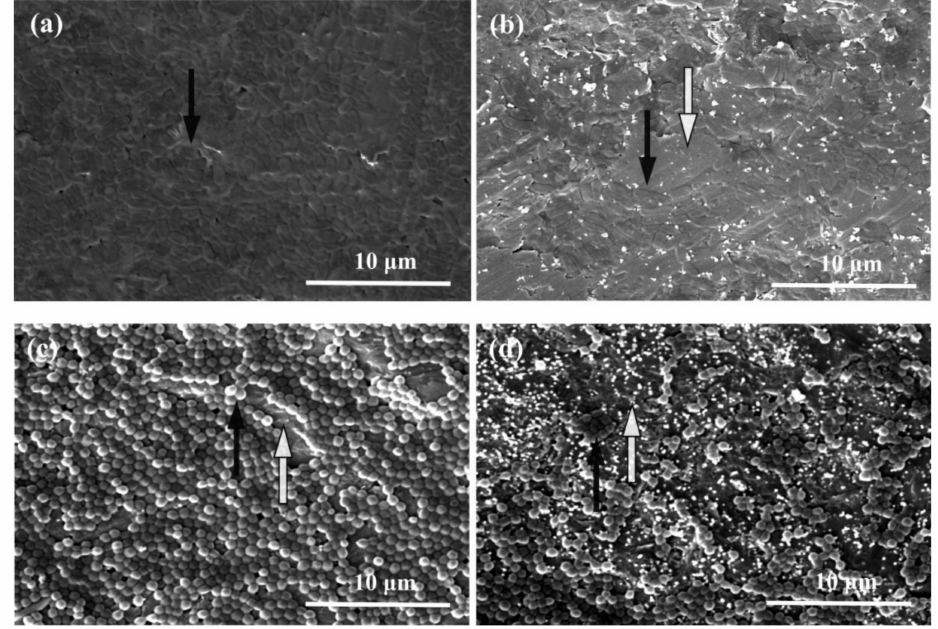
Figure 6. SEM micrographs of the aspect of the biofilm after inoculating P. aeruginosa ( a and b ) and S. aureus ( c and d ) on the RHA2.5Se ( b and d ) coatings compared to HA ( a and c ). White arrows indicate non-colonized areas and black ones indicate the shape of an exemplar of that bacterium. Reprinted from [54] with permission from John Wiley and